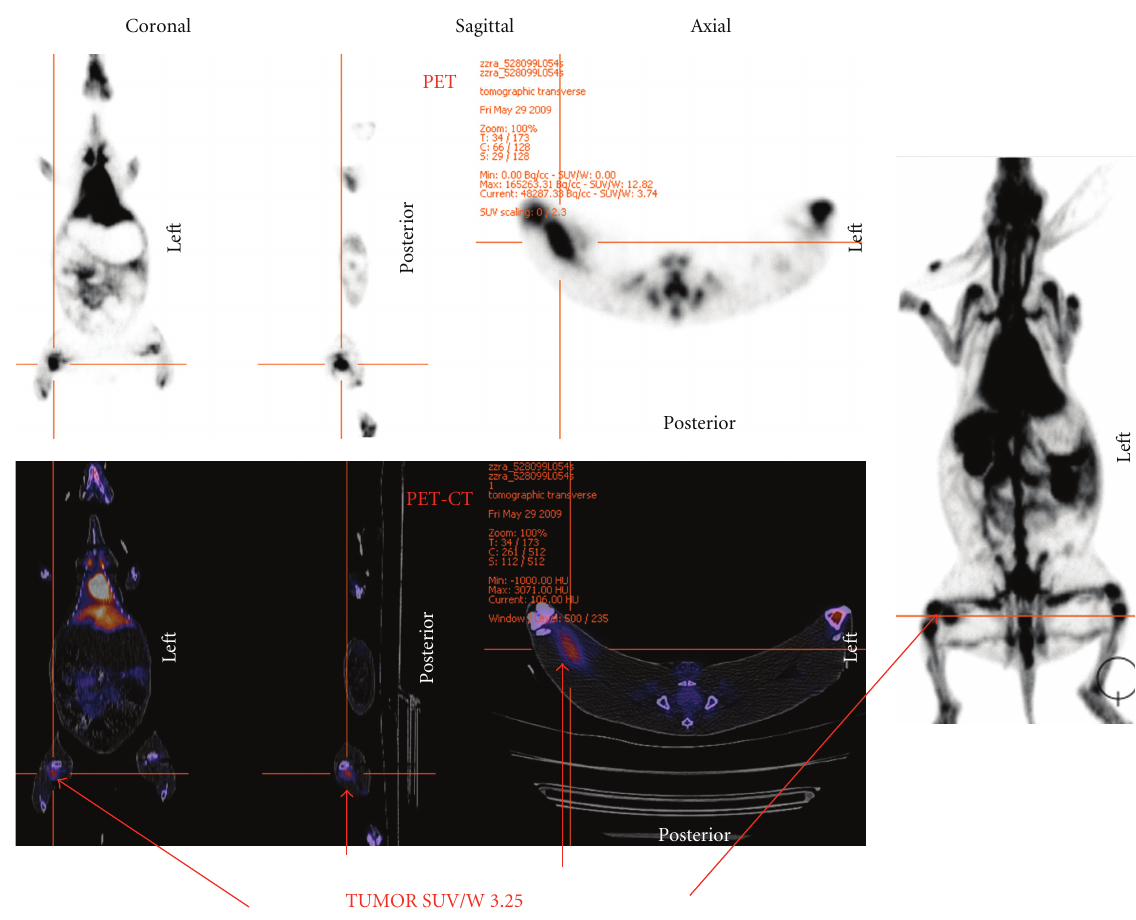
Figure 7: 45 minutes dynamic image with PET-CT of 68 Ga-GP in a New Zealand white rabbit bearing VX2 tumor showed SUV of the tumor was